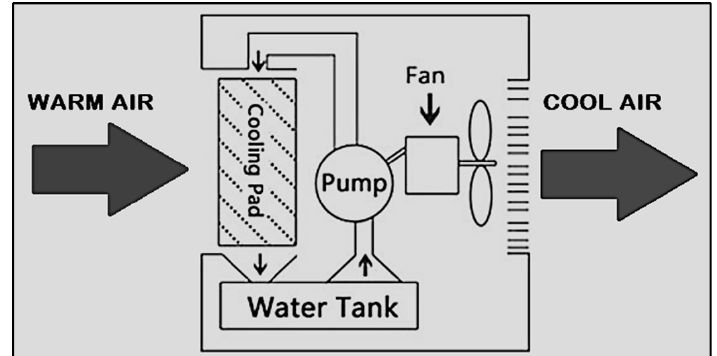
Figure 1. Conceptual scheme of an evaporative cooling pad. When humid air is evaporatively cooled, its dry bulb temperature is decreased close to its wet-bulb temperature via heat and mass transfer. Evaporative cooling can be initiated either from a humid surface or by spraying water directly into the air to achieve